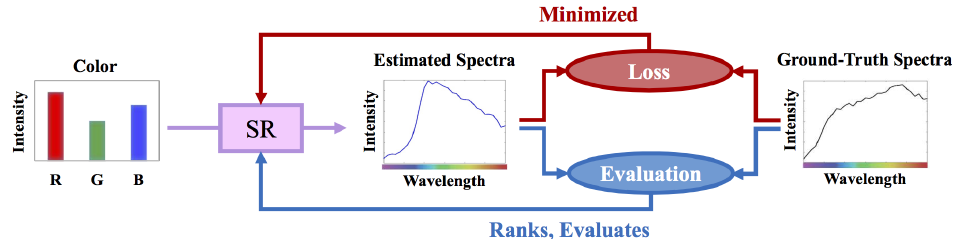
Figure 1. The standard spectral reconstruction (SR) training and evaluation